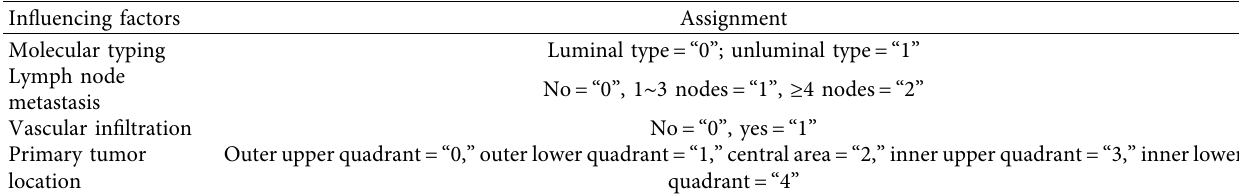
Table 3: Assignment for multivariate analysis of factors.